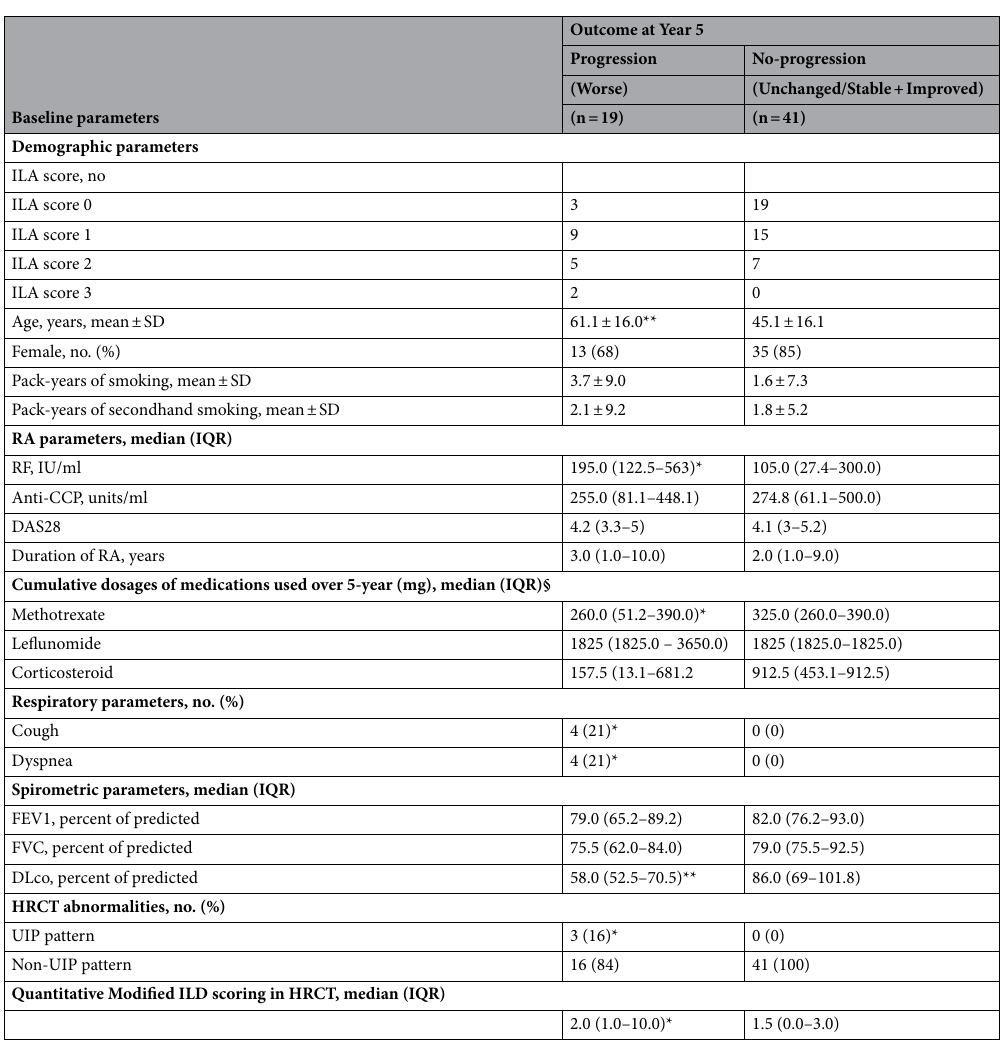
Table 2. Baseline parameters and disease outcome at Year 5. RA-ILD outcomes at Year 5 were defined as progression versus no-progression based on changes of the Quantitative Modified ILD HRCT scores from Year 0 to Year 5. Unchanged/stable (≤ 10% change) and improved (≥ 10% decrease) in the Quantitative Modified ILD scores were designated as no-progression, while worsening scores (> 10% increase in Quantitative Modified ILD scores) were classified as progression. Among the 56 patients who were alive at Year 5, 39 had available PFT data from both Year 0 and Year 5 time points. Baseline age, RF, cough, dyspnea, DLco% and non-UIP HRCT pattern in the progression group were significantly different compared to the no-progression group ( p < 0.01, 0.05, 0.05, 0.01, 0.05, 0.05, respectively). The cumulative dosage of methotrexate (mg) used over 5-years in the progression group was significantly lower than in the no-progression group ( p = 0.027). § The percentages of patients using methotrexate, leflunomide and corticosteroid in the progression group were 100%, 42%, and 21%, respectively. The percentages of patients using methotrexate, leflunomide and corticosteroid in the no-progression group were 100%, 53% and 15%, respectively. Median (IQR) values for cumulative medication dose were assessed across entire subgroups (progressors vs. non-progressors), but only encompassed those individuals who used the specified medication during the 5 year study period. * p < 0.05, ** p < 0.01, *** p < 0.001, progression group versus non-progression group respectively. p -values were derived from two samples t-test/Mann–Whitney U test (continuous variables) and Chi-square /Fisher’s exact test (categorical